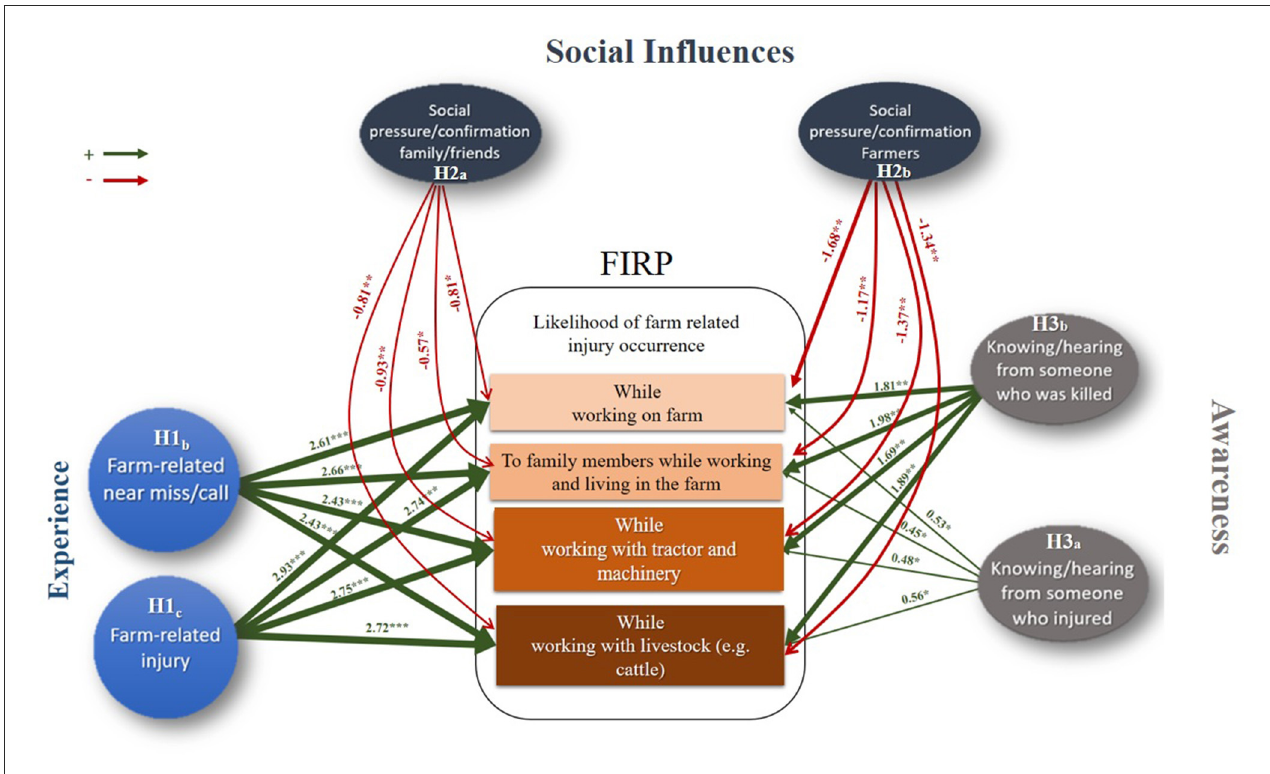
FIGURE2 Experimental model of factors affecting FIRP.